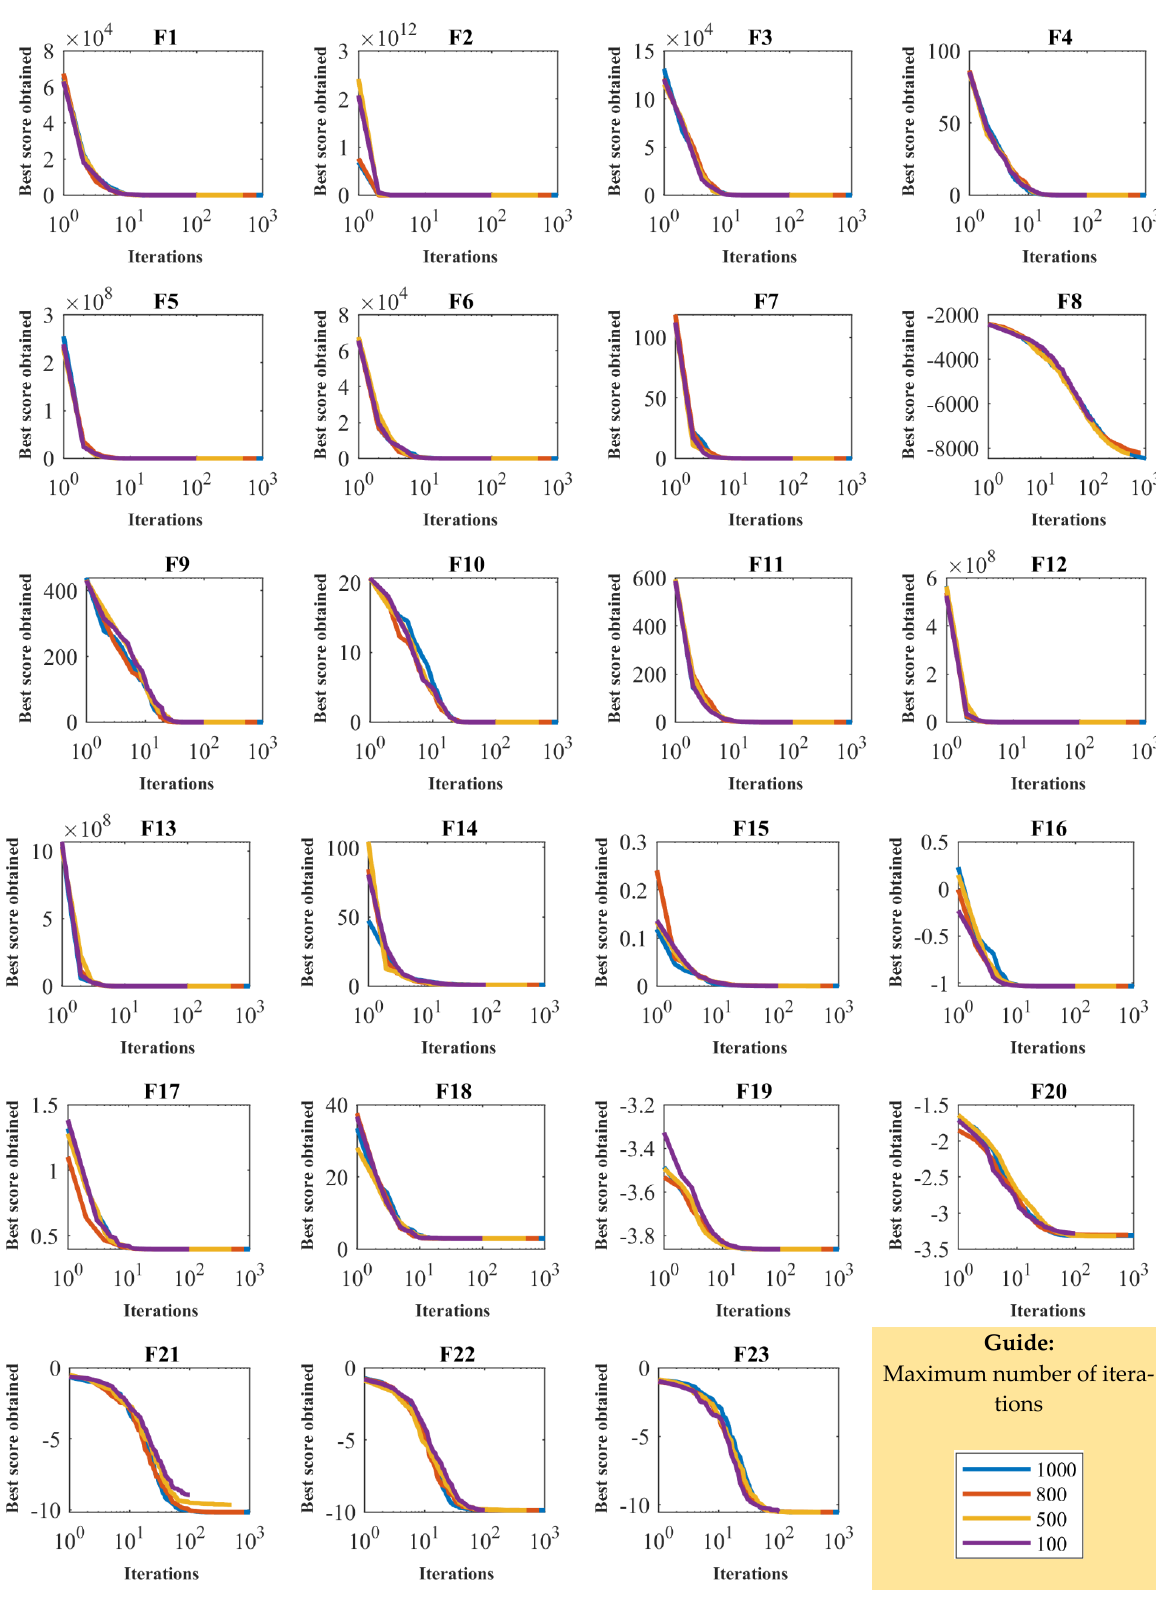
Figure 4. Sensitivity analysis of the POA to T parameter. In order to analyze the sensitivity of POA to the parameter 𝑅 , it should be noted that the coefficient “ 𝑅 ∙ (1 − 𝑡/𝑇) ” indicates that in each iteration, the maximum change for each member of the population is “ 𝑅 ∙ (1 − 𝑡/𝑇) ” times its current position. Therefore, the value of the parameter R in this coefficient must be less than one. The proposed POA for different values of 𝑅 equal to 0.1, 0.2, 0.3, 0.4, 0.5, 0.6, 0.7, 0.8, 0.9, and 1 is employed in the optimization of the F1 to F23 function. The optimization results of F1 to F23 functions for different values of parameter 𝑅 are reported in Table 8. The results of this sensitivity analysis show that the POA has a very low sensitivity to changes in the parameter 𝑅 and in most cases provides the same solution. In optimizing of the functions F6, F9, F10, F11, F14, F15, F16, F17, F18, and F19, the different selected values for the parameter 𝑅 had no effect on POA performance. In the general analysis and comparison of the results, it was found that POA has the best performance for the value of 𝑅 equal to 0.2. Table 8. Sensitivity analysis of the POA to R . OF R value 0.1